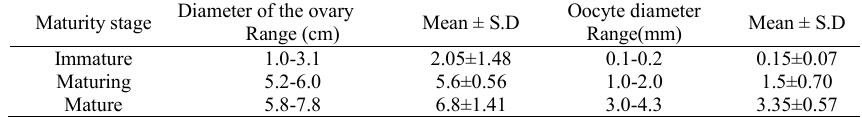
Table 2. Relationships between the diameter of the ovary and oocyte diameter of female silky